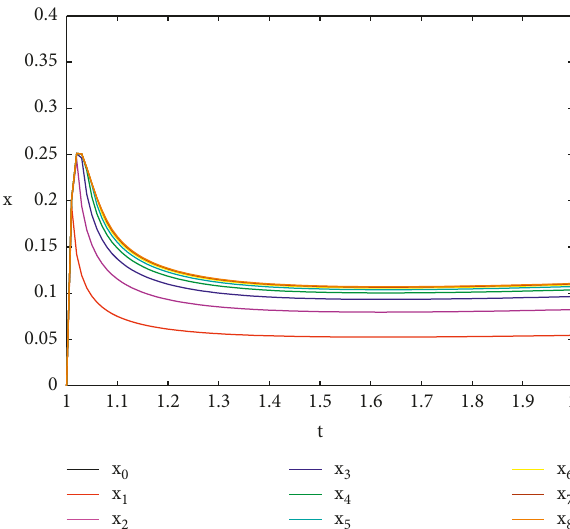
quence of equation (31) under the Hadamard fractional derivative for α � 0 .